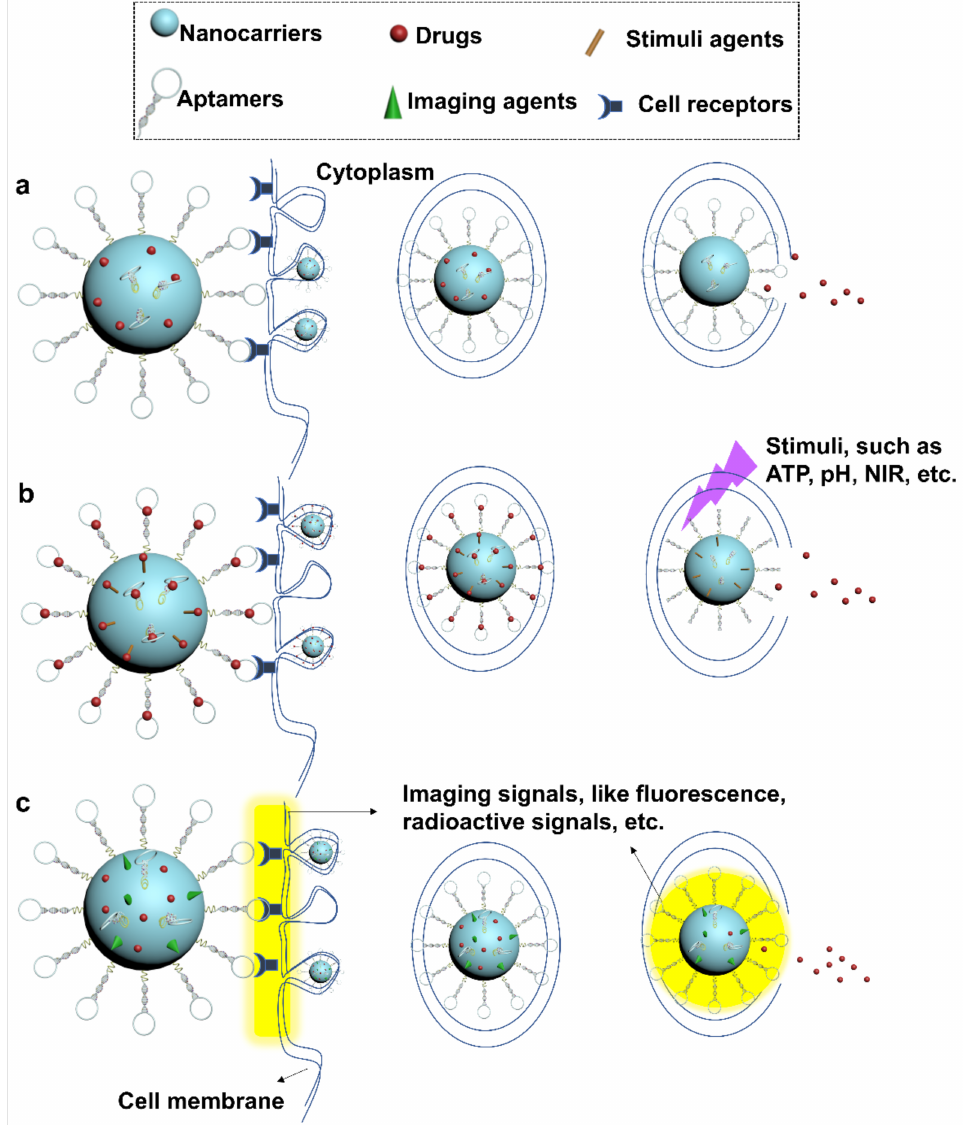
Figure 2. Applications of aptamer-functionalized drug delivery nanocarriers. Aptamer-incorporated drug nanocarriers can be designed for ( a ) targeted drug delivery, ( b ) controllable drug release, and ( c ) imaging-guided therapy. In ( b ), drugs captured by conformation-switchable aptamers or other stimulus-responsive agents can be programmatically released in response to the environmental stimuli. In ( c ), imaging signals can be designed to release with payloads or upon binding to target cells, enabling guiding and tracking of therapeutics in